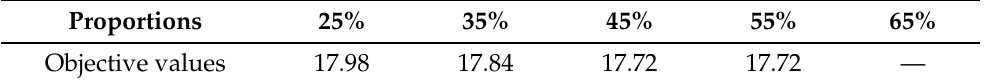
Table 5. Different proportions of drone surveillance targets in the initial